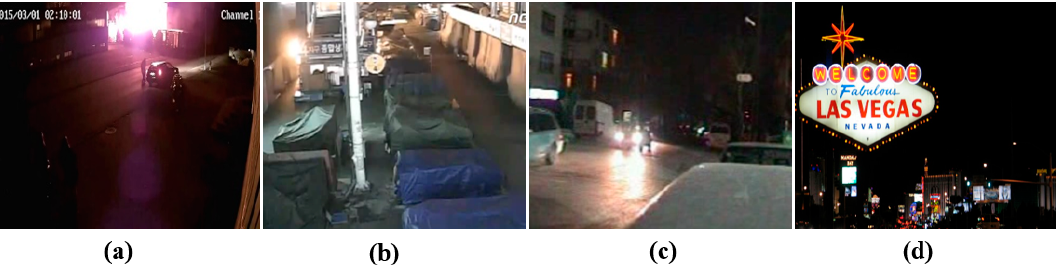
Figure 1. Examples of night-time fire and night-time fire-like lights: ( a ) a constantly changing size and shape of the fire without color information, ( b ) fire occurring in the corner of the building, ( c ) fire-like streetlight and car headlight, and ( d ) fire-like neon sign.